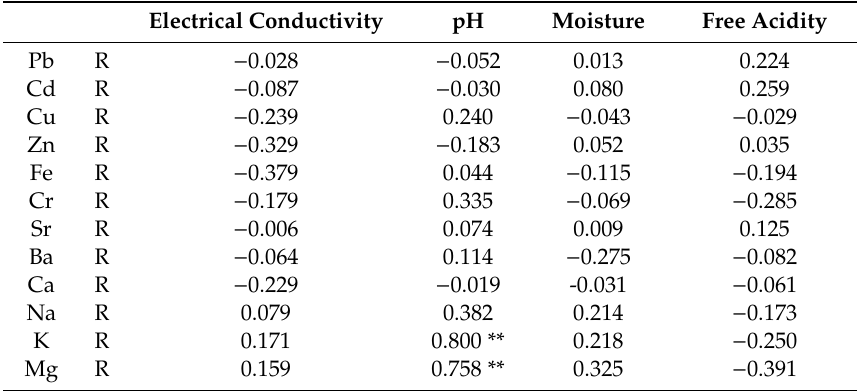
Table 2. Results of the correlation analysis between the mineral content and physicochemical parameters of analyzed honey samples from